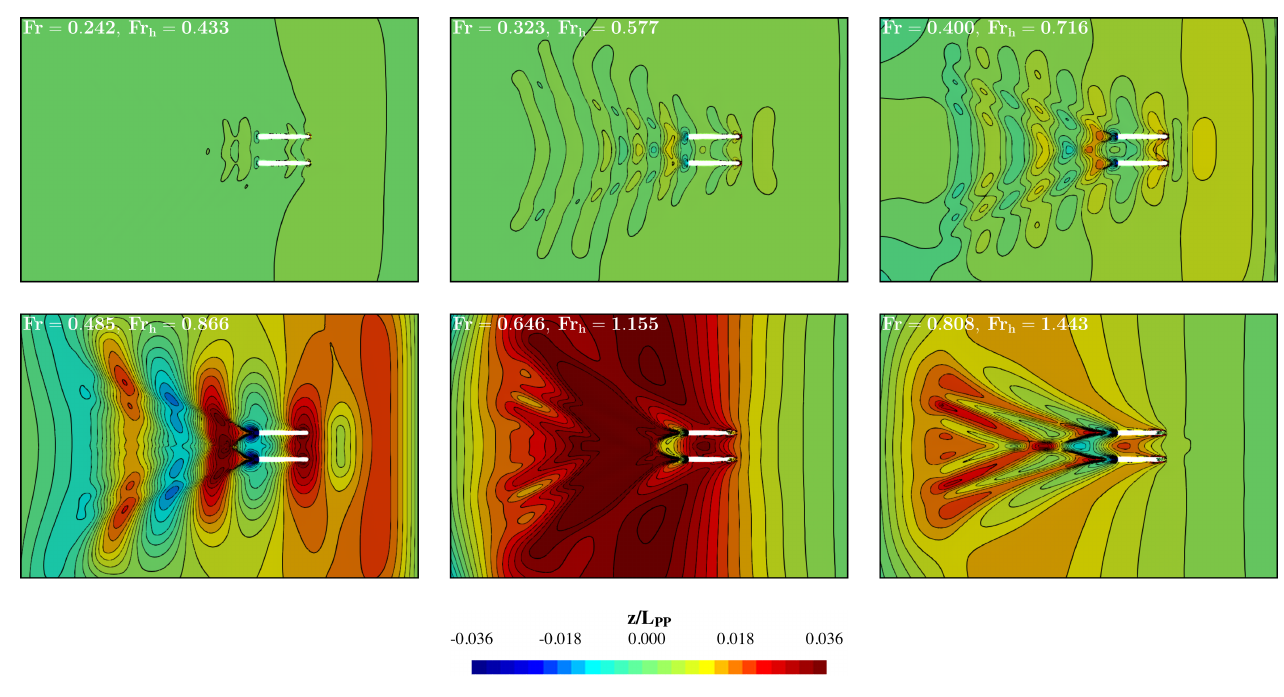
Figure 10. Wave elevation at z = 0.25